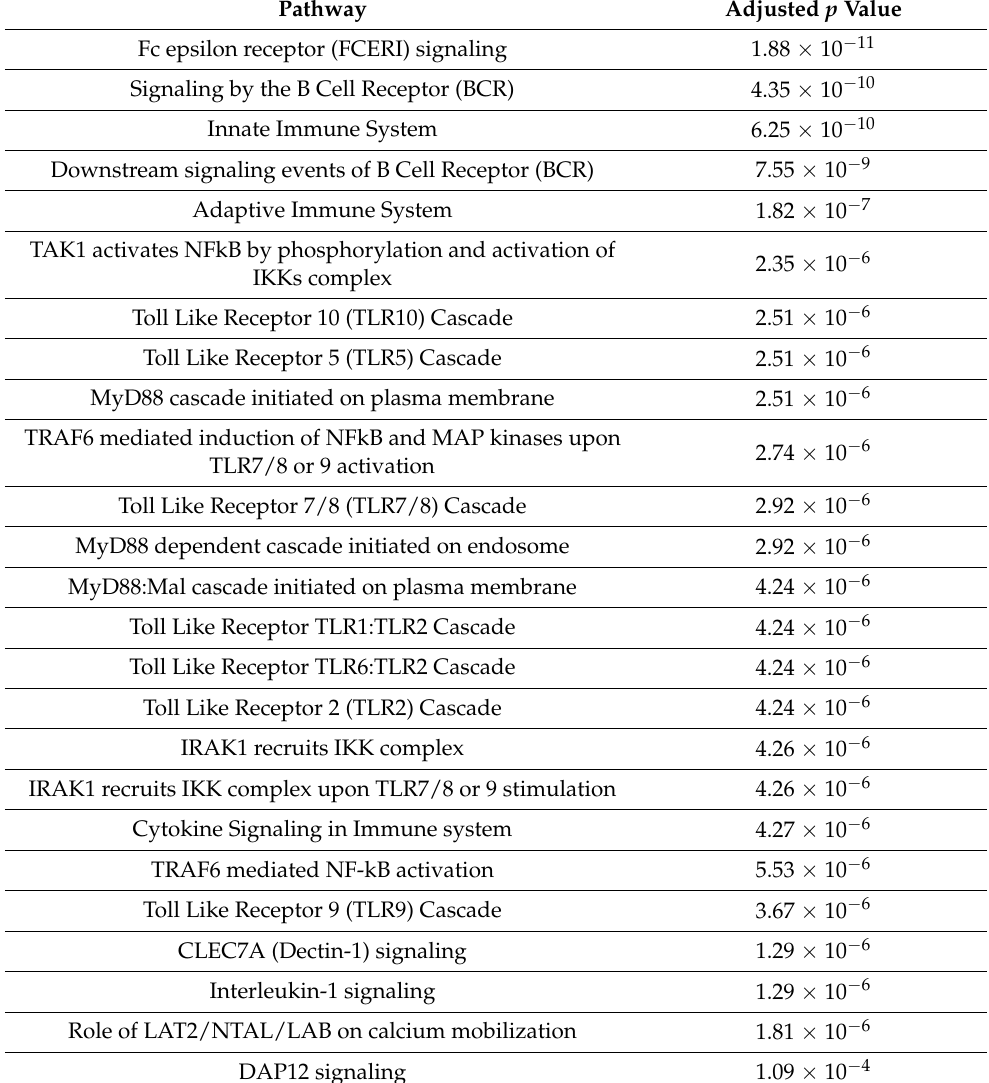
Table 2. Top 25 pathways related with immune